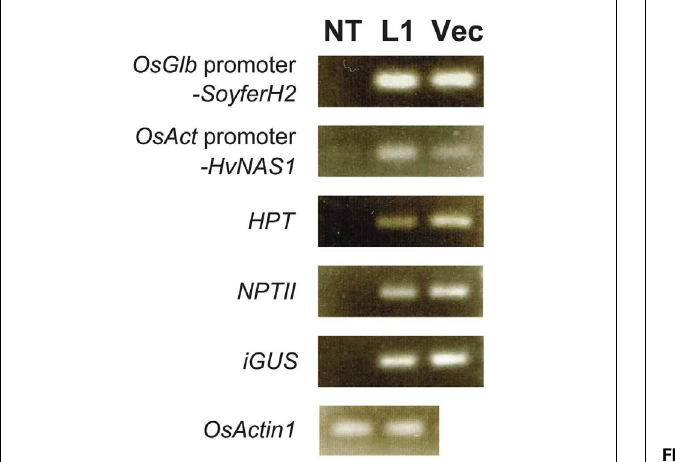
FIGURE 6 | Confirmation of gene insertion in transgenic Paw San Yin-Fer-NAS-YSL2 line 1 . NT, non-transgenic Paw SanYin line; L1, Paw San Yin-Fer-NAS-YSL2 line 1;Vec, Fer-NAS-YSL2 vector (positive control). OsGlb promoter- SoyferH2 , soybean Ferritin gene SoyferH2 with promoter region of the 26kDa OsGlb1 gene; OsAct promoter -HvNAS1 , barley nicotianamine synthase 1 gene with promoter region of the rice OsActin1 gene; HPT , hygromycin phosphotransferase gene; NPTII , neomycin phosphotransferase II gene; iGUS , β -glucuronidase gene with an intron ; OsActin1 , endogenous rice actin gene.